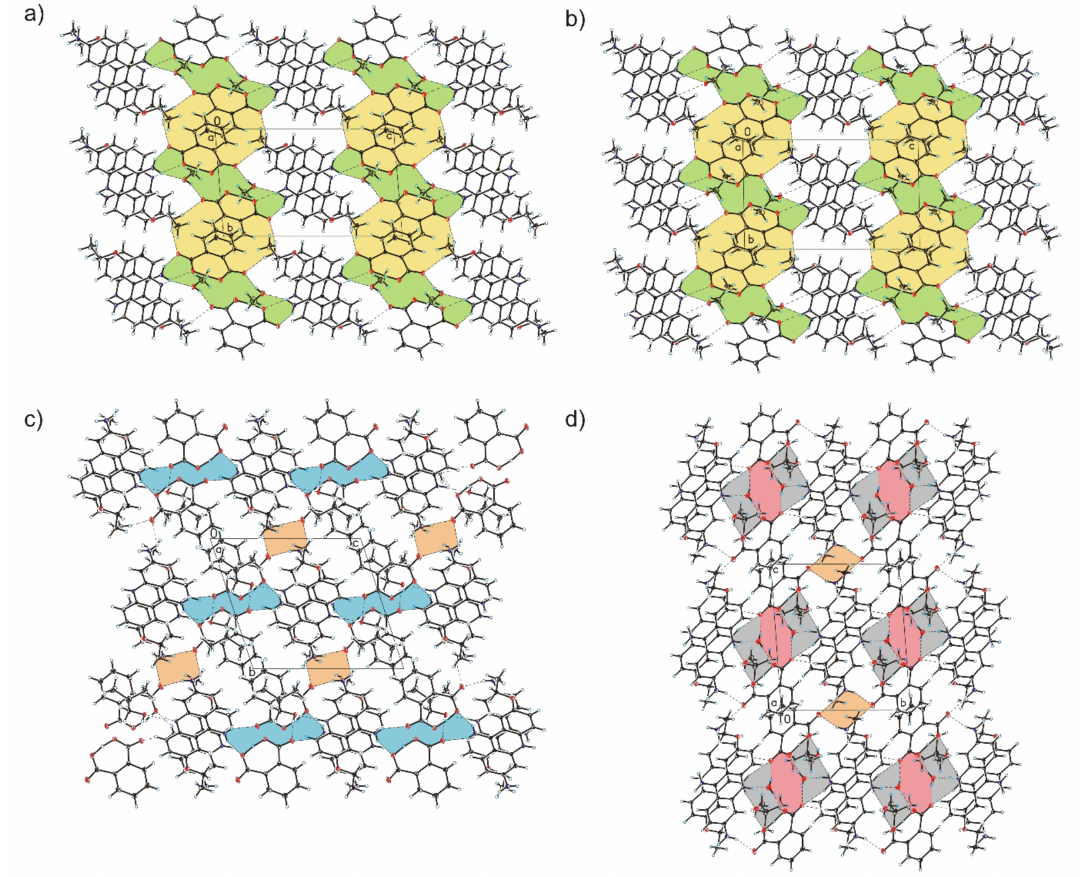
Figure 3. Crystal packing and supramolecular synthon of compounds 1 – 4 shown in ( a – d ) respectively. ( a , b ) Supramolecular synthons: [ ⋯ H–N–H ⋯ (O C O H O C O) − ⋯ ] 2 (highlighted in yellow), and [ ⋯ H–N–H ⋯ O–H ⋯ (O C O H O C O) − ⋯ ] 2 (highlighted in green). ( c ) Supramolecular synthons: [ ⋯ H–N–H ⋯ (O H O C O) − ⋯ ] 2 (highlighted in blue),